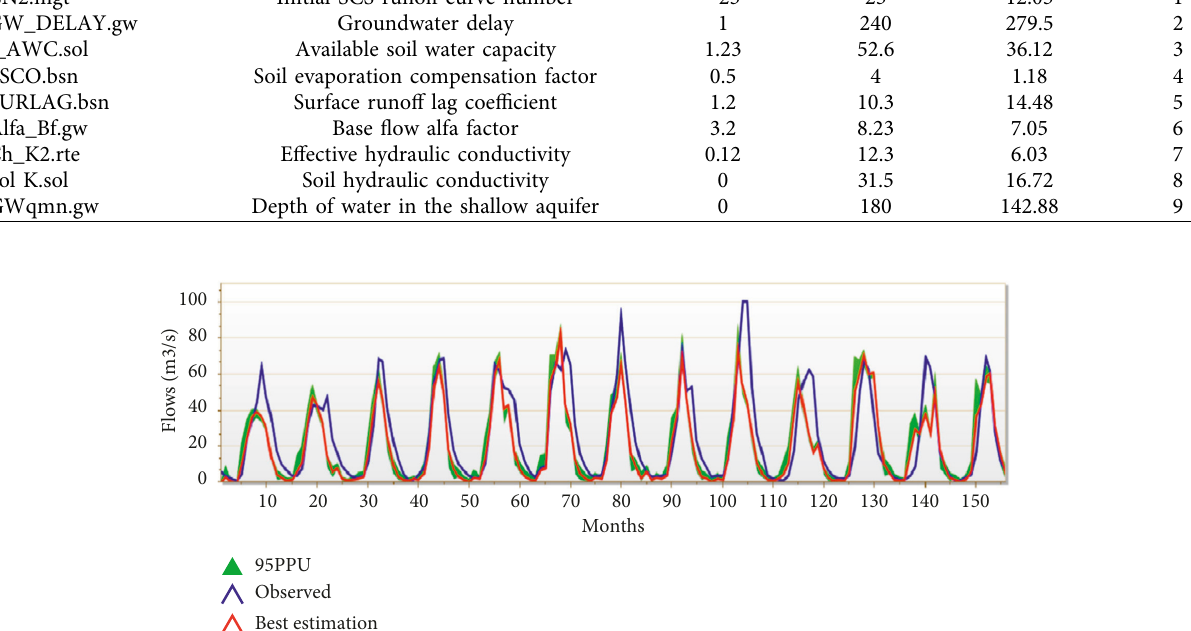
Figure 3: Validation of streamflow result with RACMO22T model.